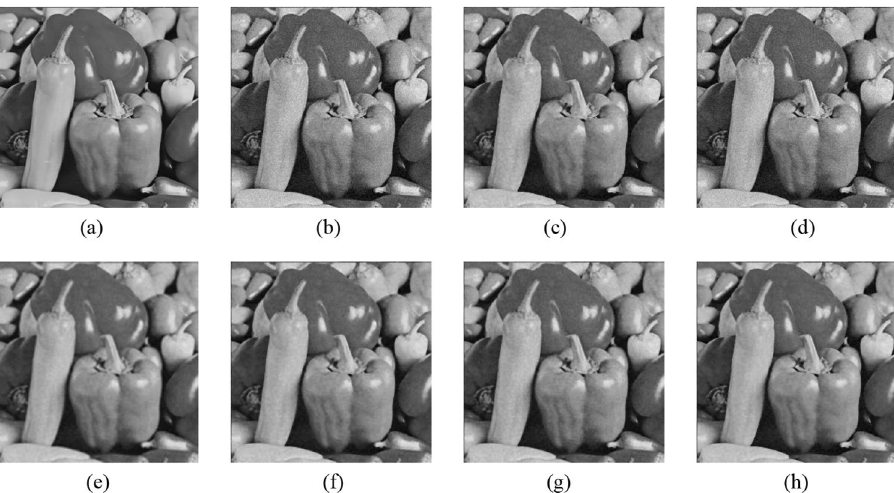
Figure 21. Comparison of denoising performance of each filter against the Gaussian noise (“Pepper”). ( a ) Original image; ( b ) noise-added image; ( c ) filtered image using abwFMGFI; ( d ) filtered image using NLMF